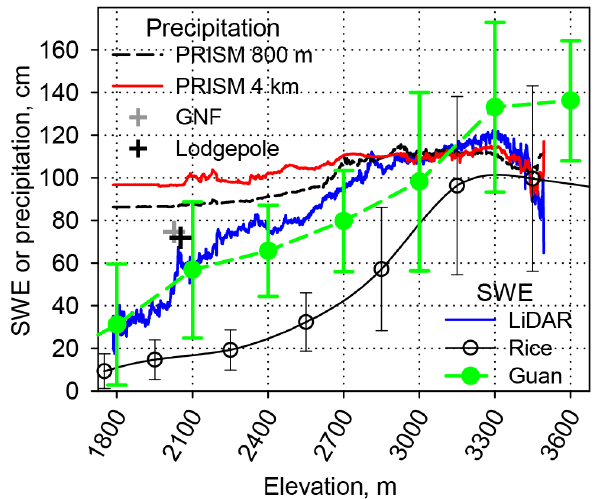
Figure 9. Elevation trend of cumulative precipitation for the Kaweah River watershed for two scales of PRISM and two recon- structions of SWE from daily snowmelt estimates, for December– March, with 23 March 2010 LiDAR SWE estimate and two cumu- lative precipitation gauge